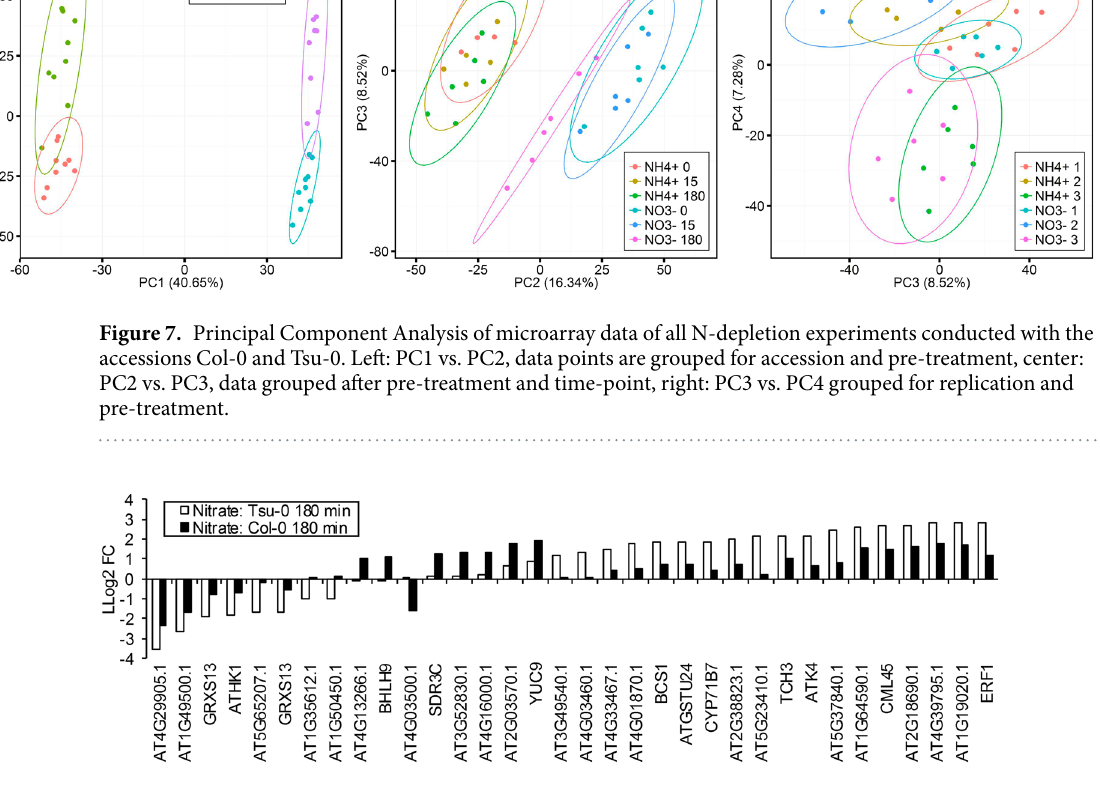
Figure 8. Accession-specific differential gene expression after 3 h nitrate depletion. Log 2 fold-changes for the genes significantly differentially regulated between the accessions were calculated between the sample 3 h after onset of